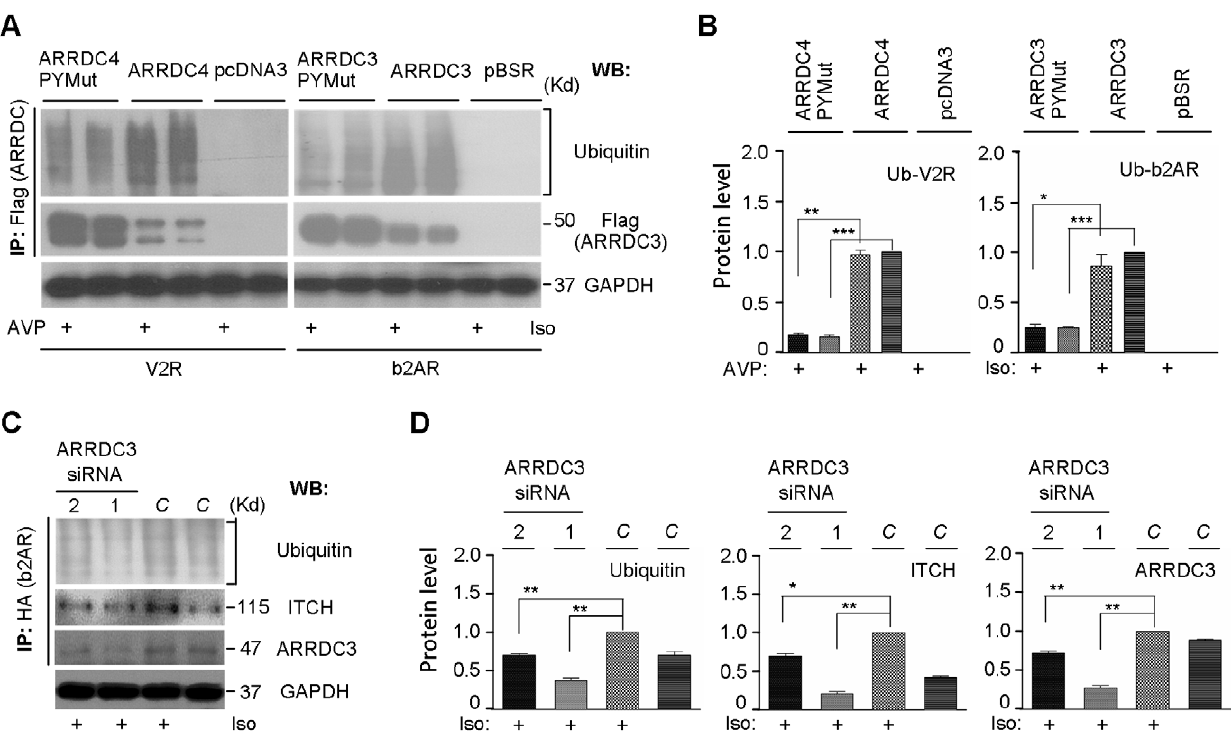
Figure 5. Biology of alpha arrestins. ( A ) Ubiquitination effect of alpha arrestins on GPCR. Empty vector, pBSR-ARRDC3-Flag, or pBSR-ARRDC3-Flag PY motif mutant construct was cotransfected with pcDNA3-HA-b2AR-V5. After 24 h incubation, cells were serum-starved for 2 h and treated or not with 1 uM Iso for 30 m. The transfected cells were lysed, and lysates were immunoprecipitated (IP) and analyzed by western blot (WB). The same experiment was performed with ARRDC4 and V2R (1 uM AVP treatment for 30 m). ( B ) The mean values ( + / 2 S.D.) of three independent experiments are included in the histogram (p value levels and lines used as in Fig. 2). ( C. ) Effects of siRNA-mediated ADDRC3 knockdown on b2AR ubiquitination and ITCH expression. Scrambled siRNA, and ARRDC3 siRNAs # 1 and # 2 were cotransfected with HA-b2AR-V5 construct. After 48 h incubation, cells were serum-starved for 2 h and treated with 1 uM Isoproterenol Iso for 30 m. The transfected cells were lysed, and the lysates were immunoprecipitated (IP) and analyzed by western blot (WB). ( D ) Histograms of mean ( + / 2 S.D.) and p-values calculated from three different experiments by paired, two-tailed t-tests comparing ligand-stimulated cells transfected with ARRDC3 siRNA versus with control siRNA (p value levels used as in Fig.